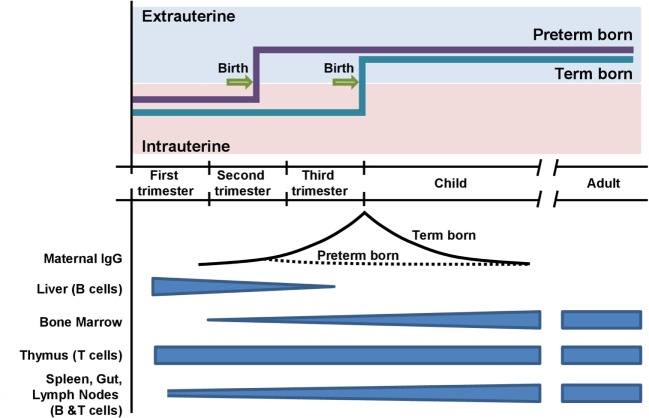
Timing of preterm and term birth in relation to the ontogeny of the adaptive immune system. Preterm neonates are exposed to extrauterine antigens before the completion of transplacental transmission of maternal IgG.